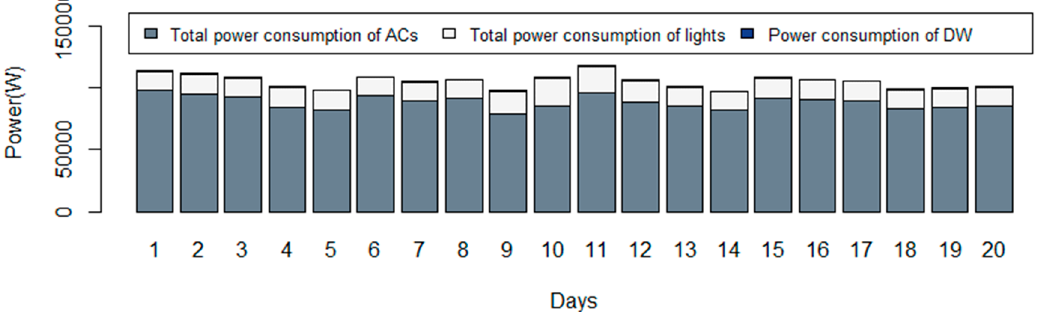
Figure 5. The power consumption of the controllable devices in each day.